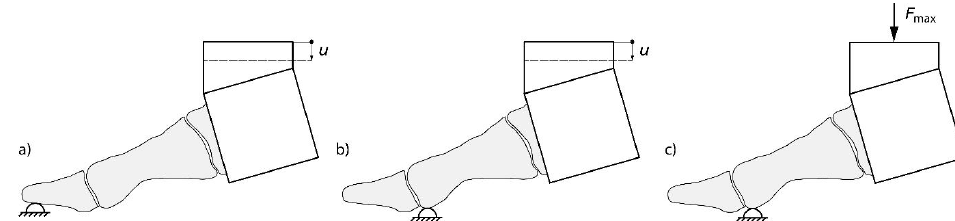
Fig. 7. Configuration of specimens under